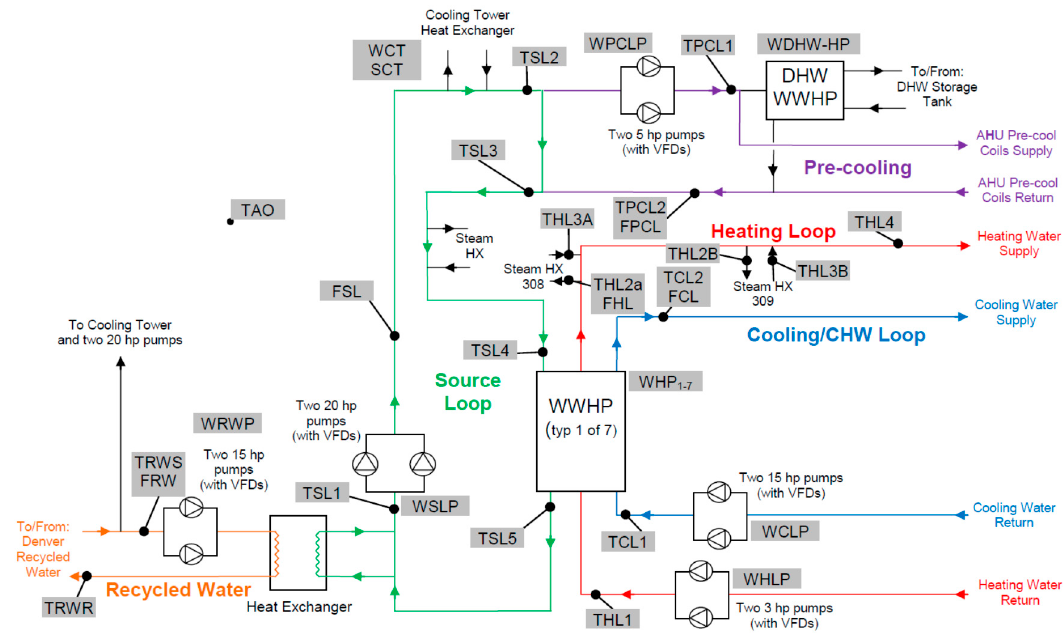
Figure 1. A schematic of the recycled water heat pump system with measured data points. VFD: variable speed drive.